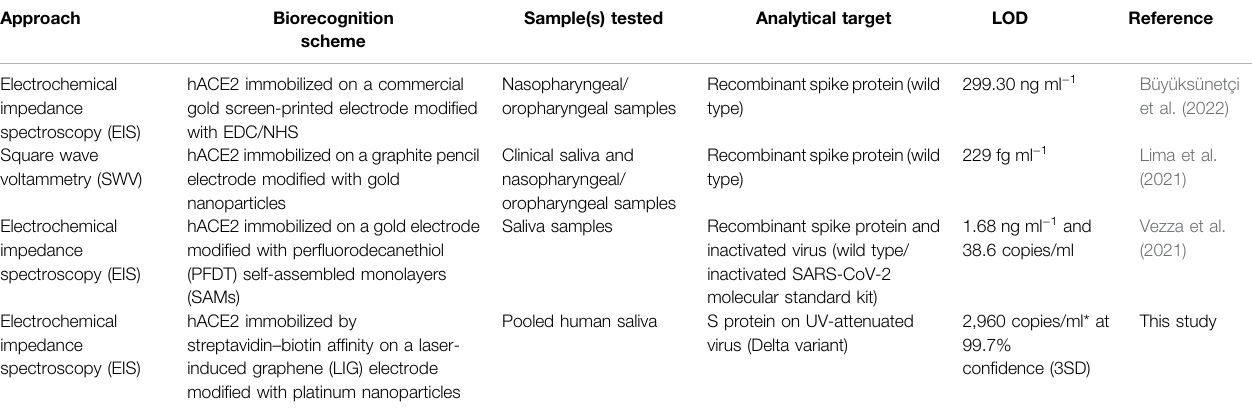
TABLE 1 | Summary of ACE2-based biosensor for SARS-CoV-2